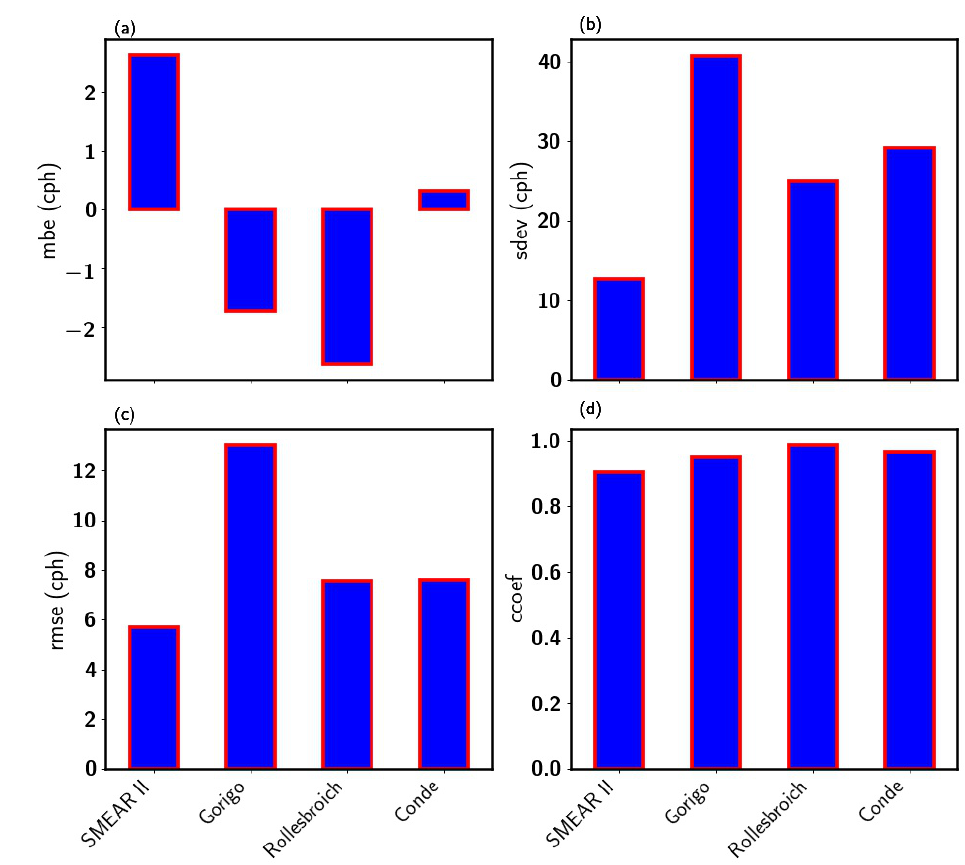
Figure 4. Performance of Kalman filter at the different station based on the MBE ( a ), standard deviation ( b ), RMSE ( c ) and correlation ( d